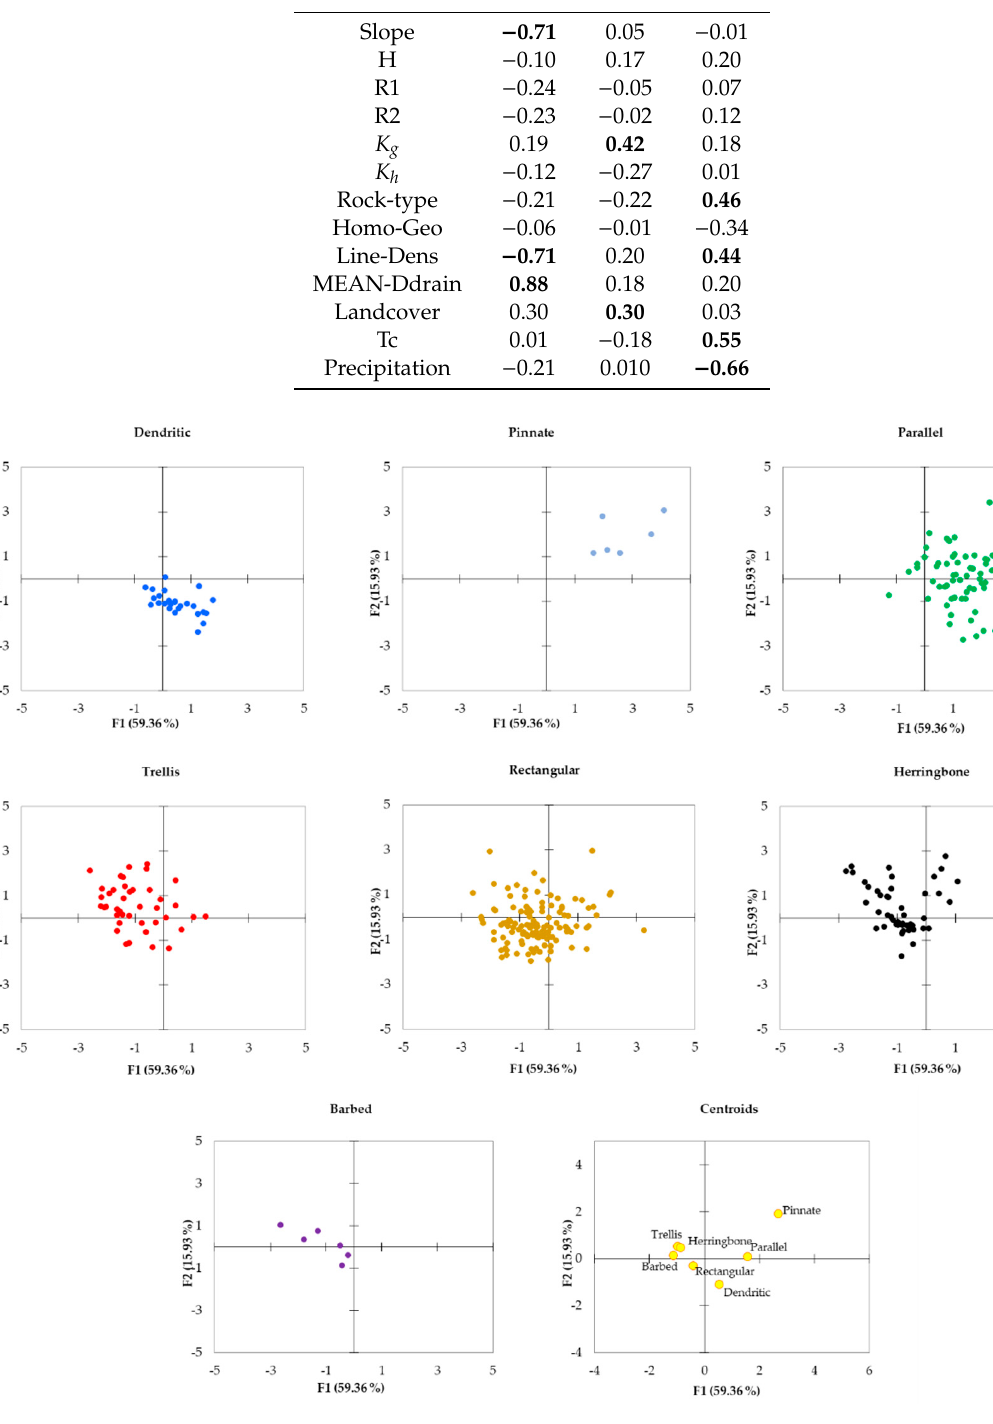
Figure 8. Distribution of the observations and centroids of each type of drainage network pattern in F1–F2 score plots (0 = Dendritic, 1 = Pinnate, 2 = Parallel, 3 = Trellis, 4 = Rectangular, 5 = Herringbone, 6 = Barbed).